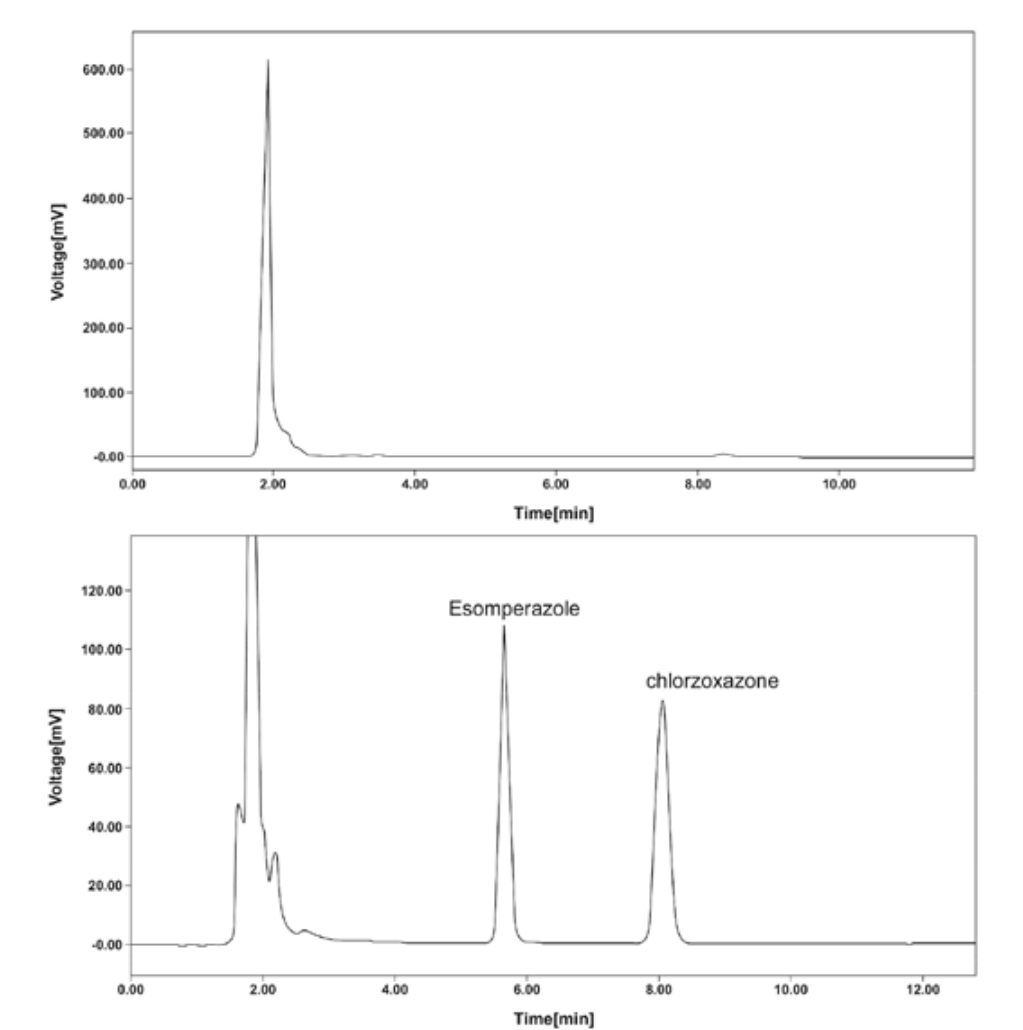
FIGURE 3 - Chromatogram of (a) blank rat ’ s plasma (b) Rat plasma spiked with chlorzoxazone (30 µg/mL) and esomeprazole (44 TABLE I - The results of Intra- and Inter-day accuracy and precision for the determination of paracetamol in rat plasma Accuracy and Precision